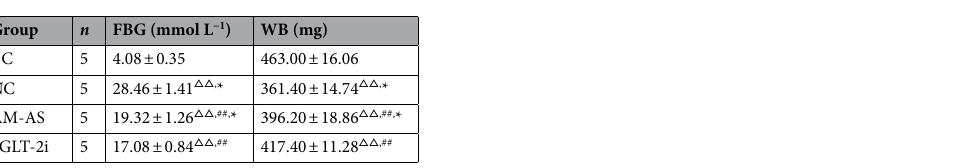
Table 4. General conditions of rats ( X ± S ). △△ P < 0.01 vs. BC, ## P < 0.01 vs. NC, * P < 0.05 vs. SGLT-2i.